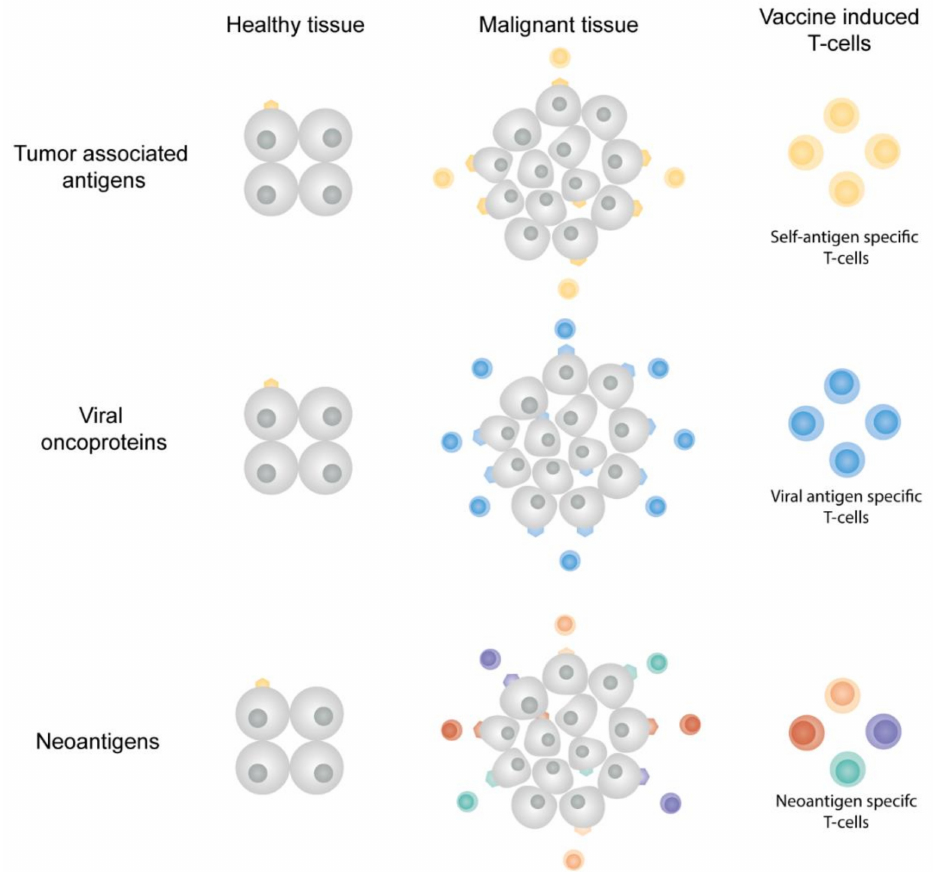
Figure 3. Antigen classes in cancer vaccines. Tumor-associated antigens are self-antigens that can be (over)expressed in tumor tissues. Vaccine-induced TAA-specific T-cells can kill both tumor cells and healthy cells. Viral oncoproteins are uniquely expressed by malignant cells in which the viral transformation resulted in tumor growth. Neoantigens originate from DNA mutations present in the cancerous cells, the neoantigens are therefore only expressed in malignant tissue. Tumor tissues often express multiple neoantigens, offering multiple vaccine targets and multiple neoantigen-specific T-cell